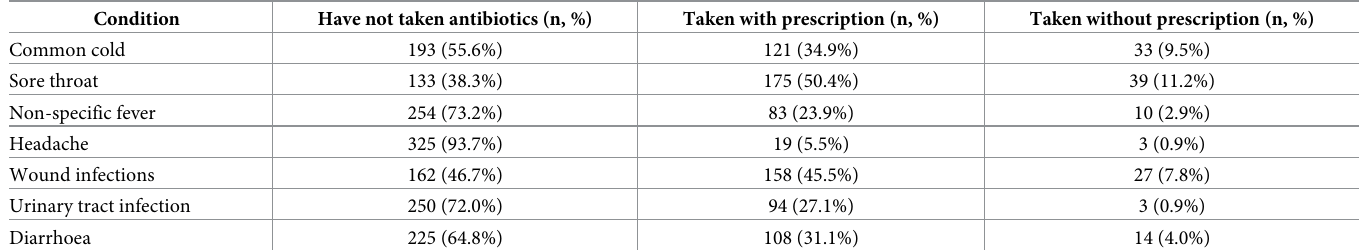
Table 1. Antibiotic use for common conditions.